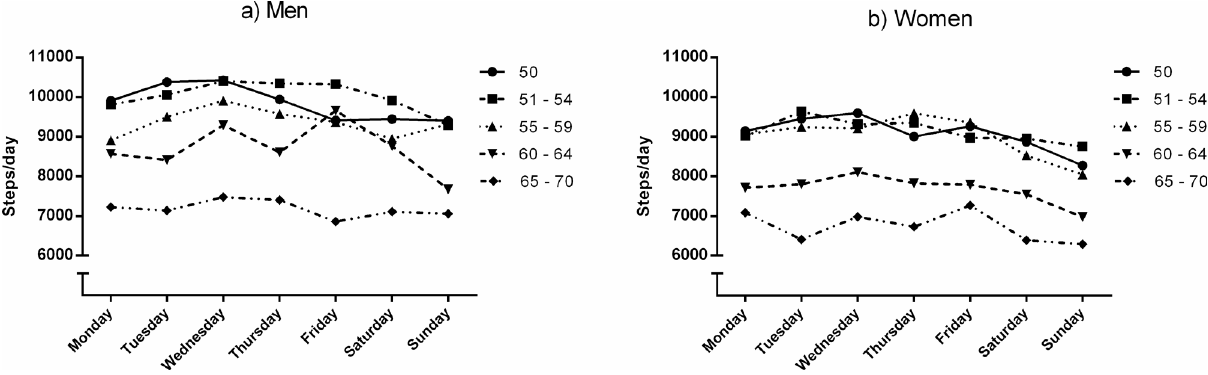
Figure 3. Variability in mean steps/day for each day of the week in five age groups in men (a) and women